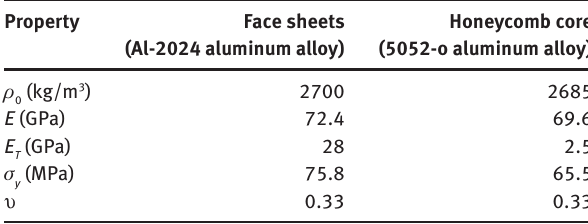
Table 1: Material properties for